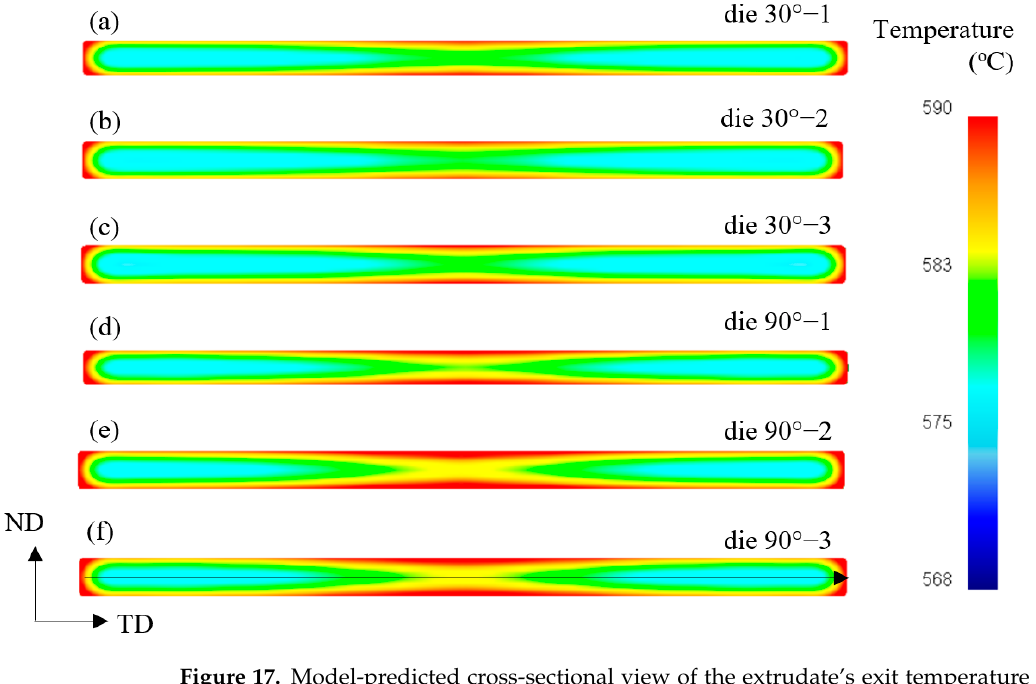
Figure 17. Model-predicted cross-sectional view of the extrudate’s exit temperature showing the effect of the upper bridge’s geometry: ( a ) die 30° − 1, ( b ) die 30° − 2, ( c ) die 30° − 3, ( d ) die 90° − 1. ( e ) die 90° − 2 and ( f ) die 90° − 3.